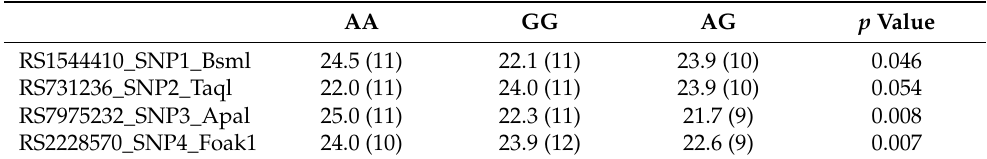
Table 2. Vitamin D concentrations (ng/mL) according to genotypes distribution of four VDR gene polymorphisms.